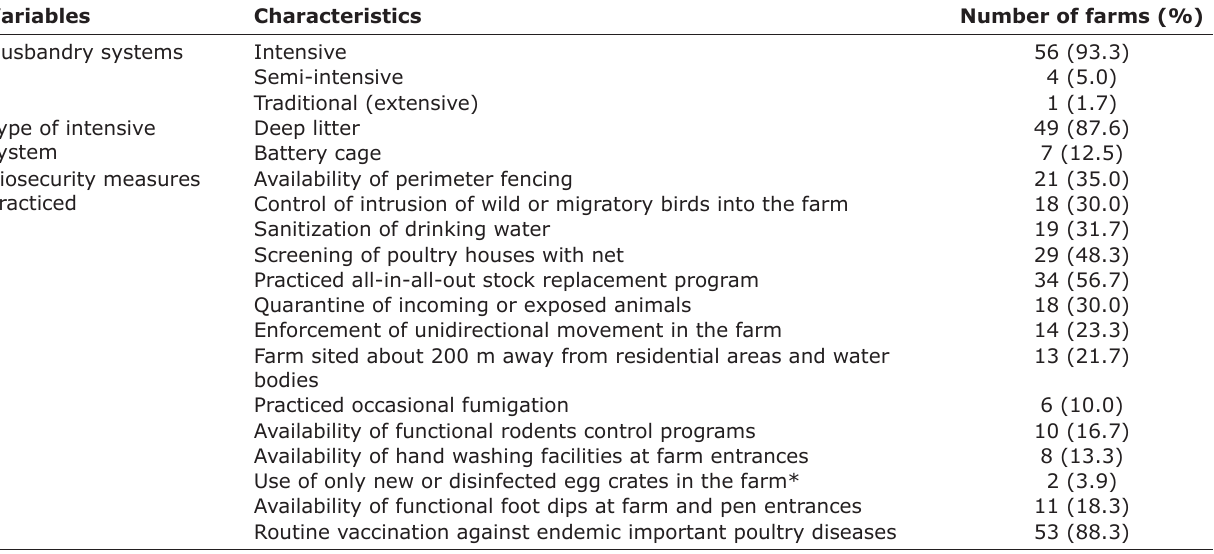
Table-1: Husbandry and biosecurity practices adopted in poultry farms (n=60) surveyed in Nsukka agricultural zone, Nigeria. Variables Characteristics Husbandry